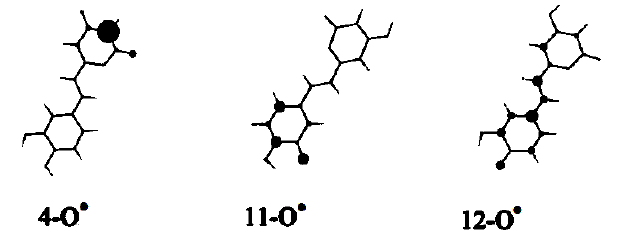
Figure 5. Spin density distribution for i-O ● styrylpyrone radicals ( a ) hispidin; ( b ) 3,14'- bihispidinyl; ( c ) hypholomine